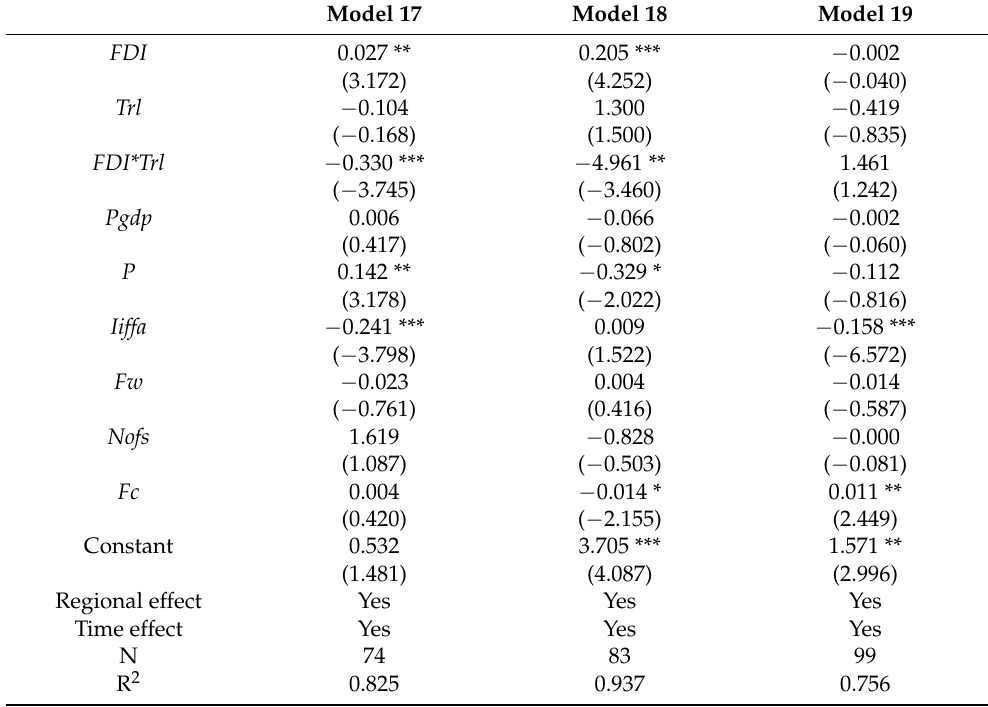
Table 8. Estimated results of the regional heterogeneity